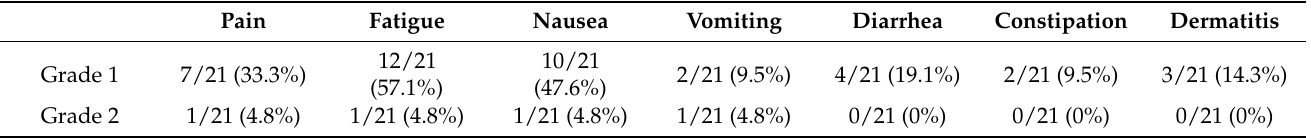
Table 3. Provider-scored acute toxicities of RT with atezolizumab plus